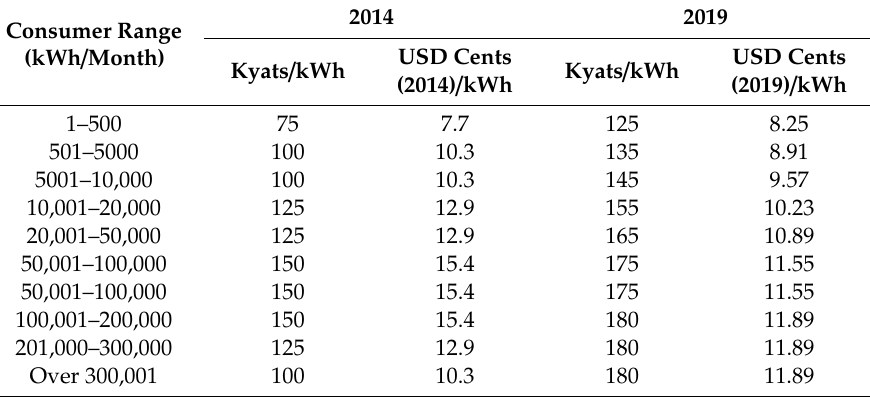
Table 3. Rates for electrical power consumption for non-domestic (industries, businesses, temporary, lamp posts, governmental buildings, state-owned industries, state-owned businesses, river water pumping stations, municipal departments, work, non-governmental organizations, embassies, international organizations) consumers in 2014 and after the tari ff hike in